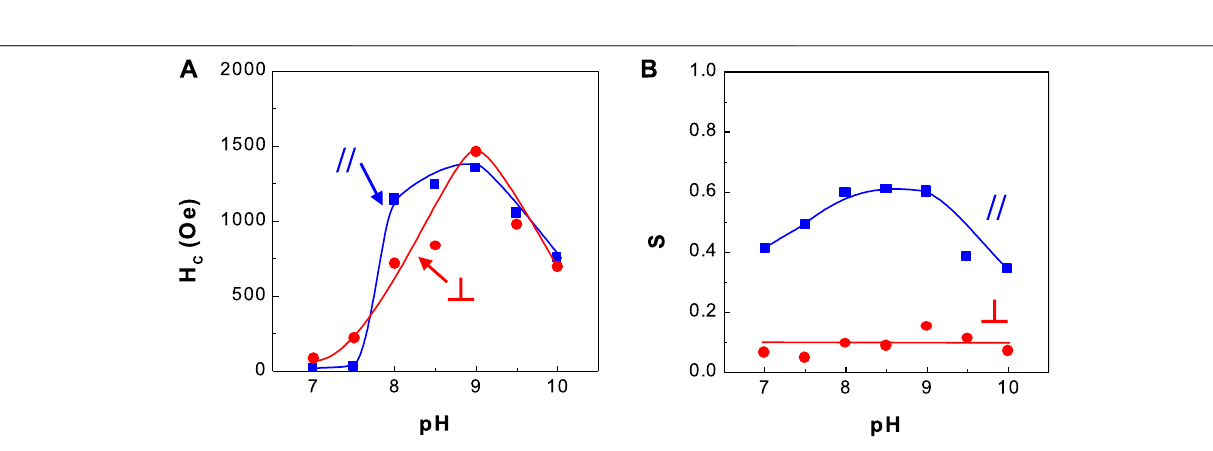
FIGURE 5 | Dependence of coercivity and squareness of CoPt thin fi lms and solution pH (A) coercivity and (B) squareness.